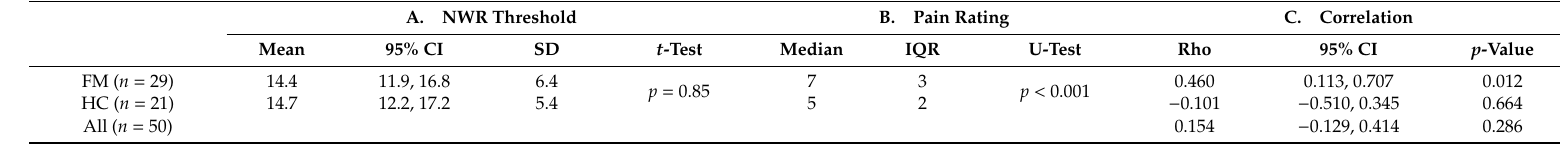
Table 2. Nociceptive withdrawal reflex (NWR) thresholds and subjective pain ratings.